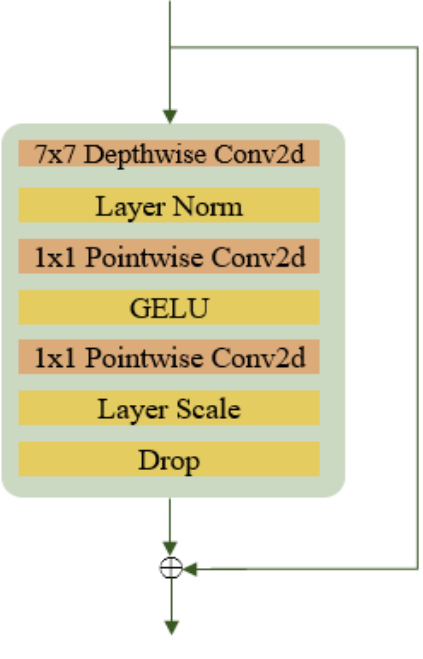
Figure 10. ConvNext block.